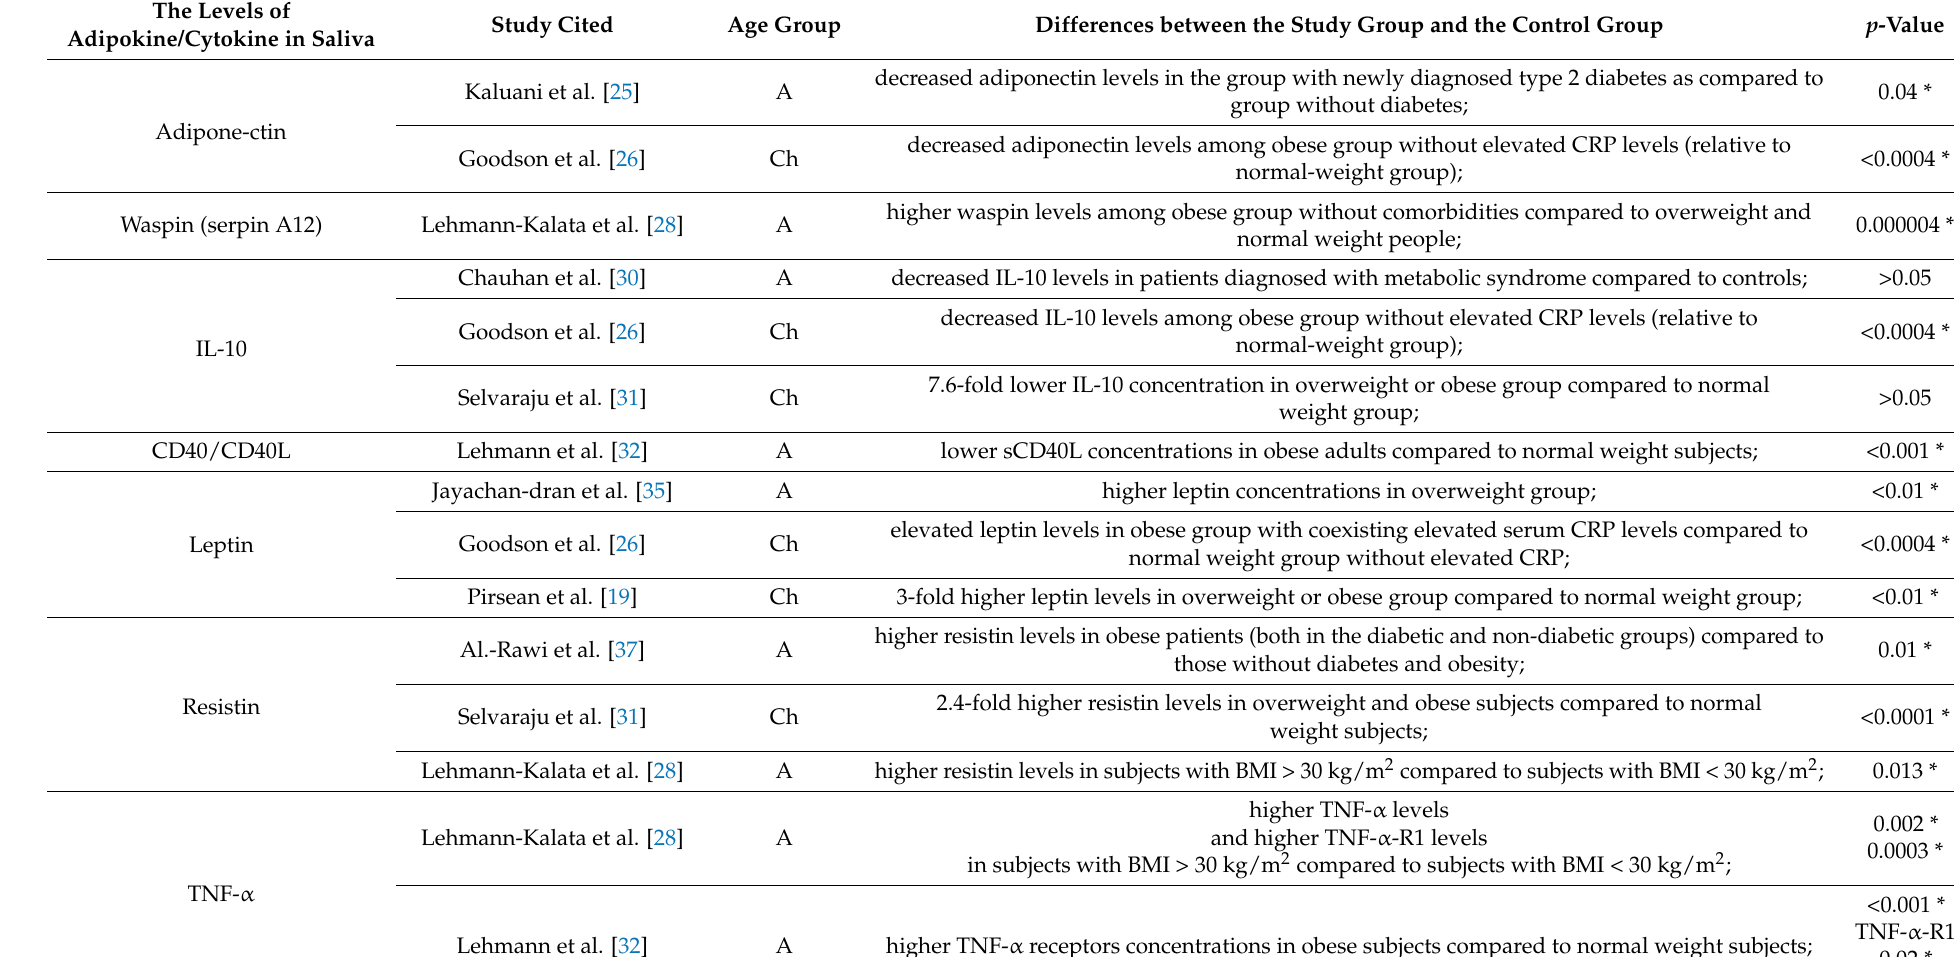
Table 2. Summary of the studies cited in the review, which showed a differences in the levels of adipokines/cytokines in saliva in the study and control